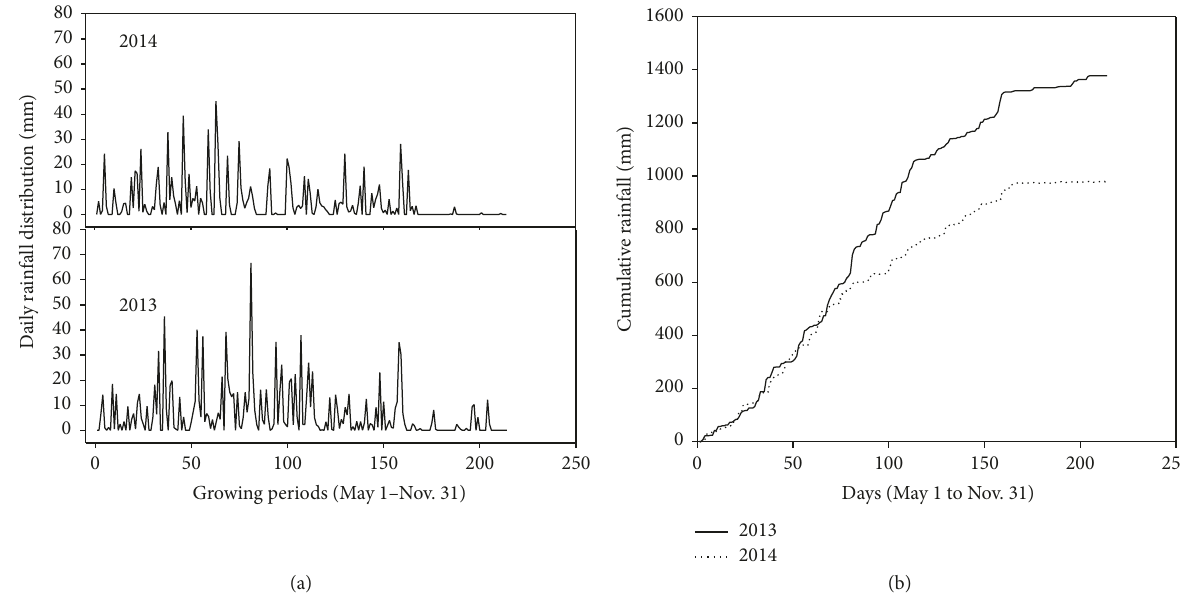
Figure 3: Daily rainfall distribution (a) and cumulative rainfall (b) received in growing periods of 2013 and 2014 rainy seasons at Bako, Western Ethiopia.